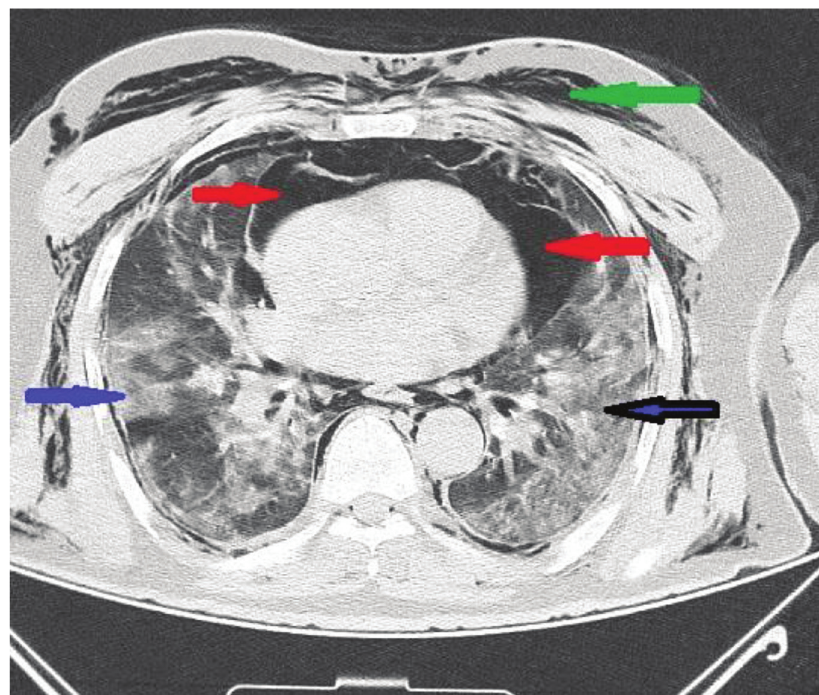
Figure 2 - Thorax computed tomography shows diffuse air density around the heart (red arrow), ground glass appearance in bilateral parenchyma (blue arrow) and diffuse air entrapment under the skin (green